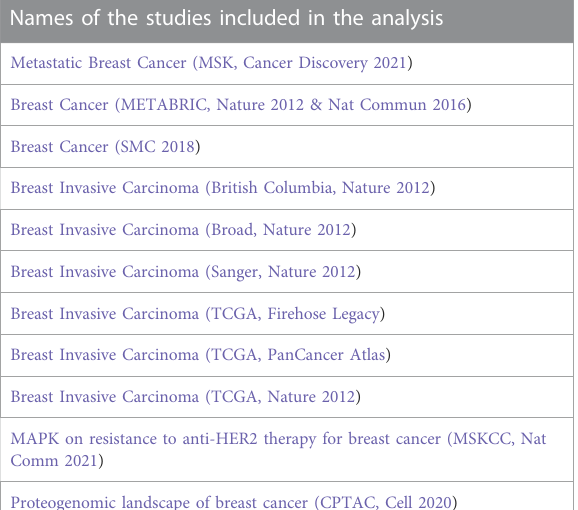
TABLE1Listofstudiesthatsatis fi edtheinclusioncriteriaandwereusedfor gene ampli fi cation analysis. Names of the studies included in the